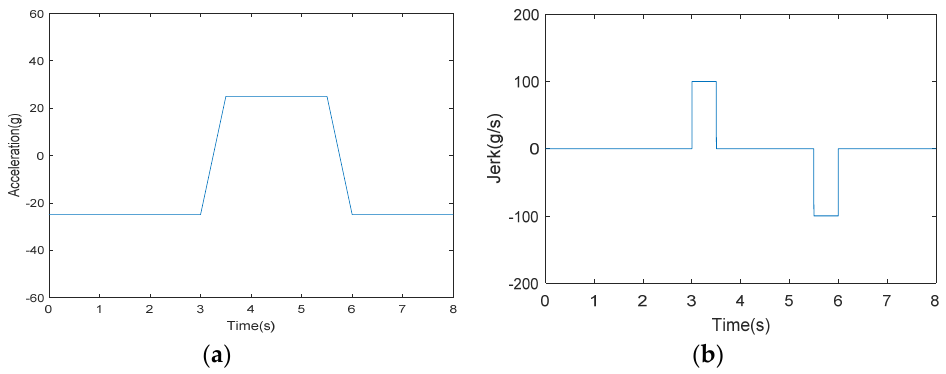
Figure 2. The trajectory of the receiver relative to the Beidou satellite. ( a ) Acceleration model for highly dynamic motion; ( b ) Jerk model for highly dynamic motion [24]. Reprinted from ref.